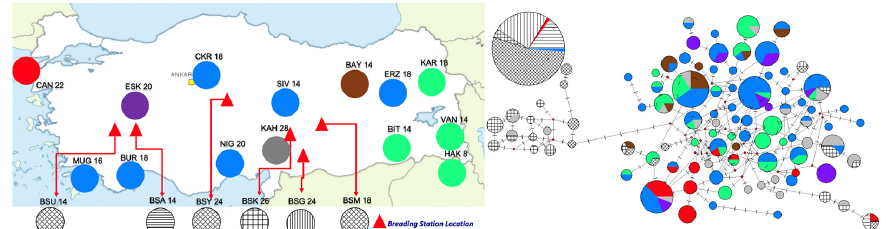
Figure 2. Heat map of mitochondrial ( a ) and microsatellite ( b ) pairwise F ST values across A. chukar populations in Turkey. Darker shades of blue rectangles indicate higher values of F ST (as displayed on the bar down of the heat map). Crosses indicate non-significant F ST p -values ( p > 0.05).